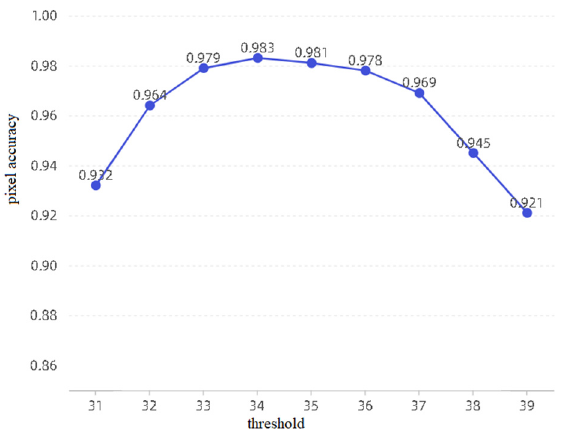
Figure 12. Comparison of the pixel accuracy with different thresholds.